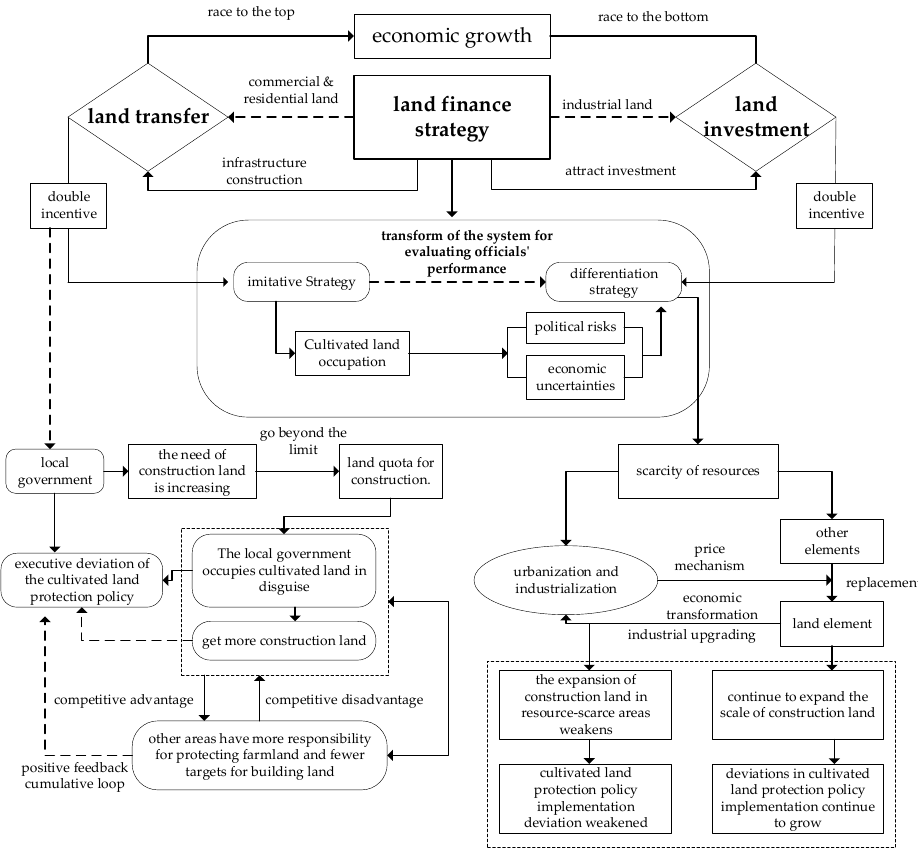
Figure 1. Influence mechanism of the interactive behavior of land-related finance strategies on the implementation deviation of cultivated land protection.